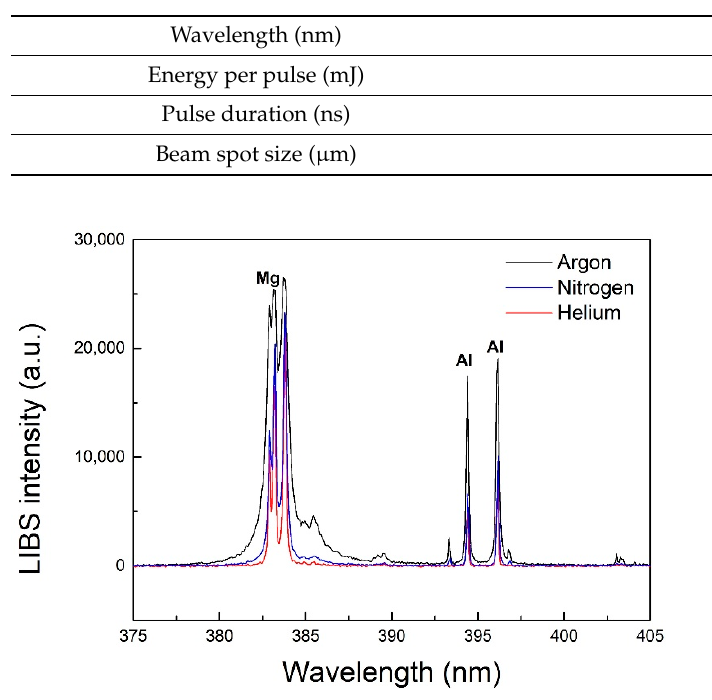
Figure 4. Graph of LIBS spectral line for a magnesium target. Table 3. Experimental parameters.